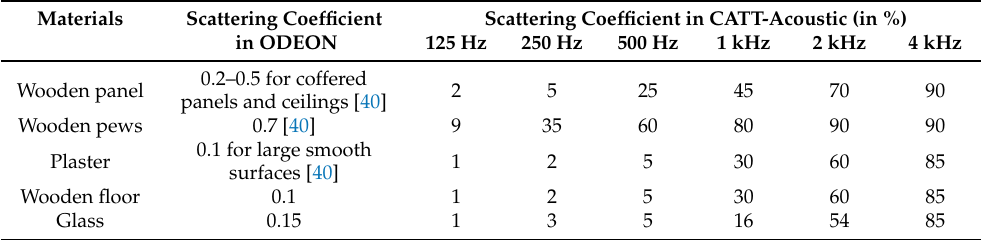
Figure 10. ( a ) Average T30 values and ( b ) C50 values with and without scattering coefficient informa- tion applied to all surfaces. Table 3. Scattering coefficients applied to the used materials in ODEON and